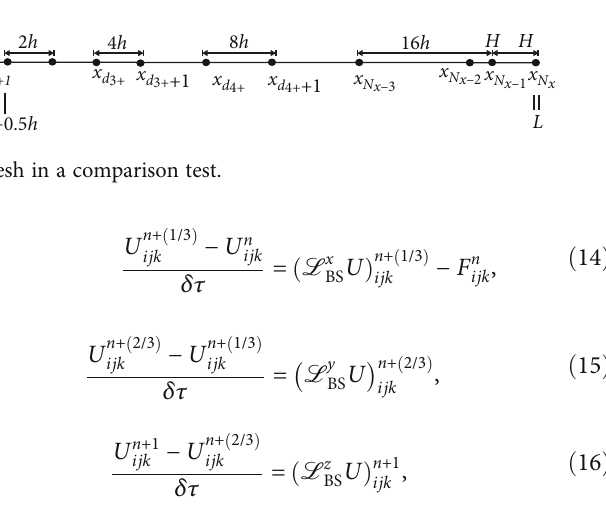
Figure 9: CPU time and price of three-asset cash-or-nothing option for nonuniform mesh with m uniform mesh with respect to h = 2, 3, ⋯ , 8 .